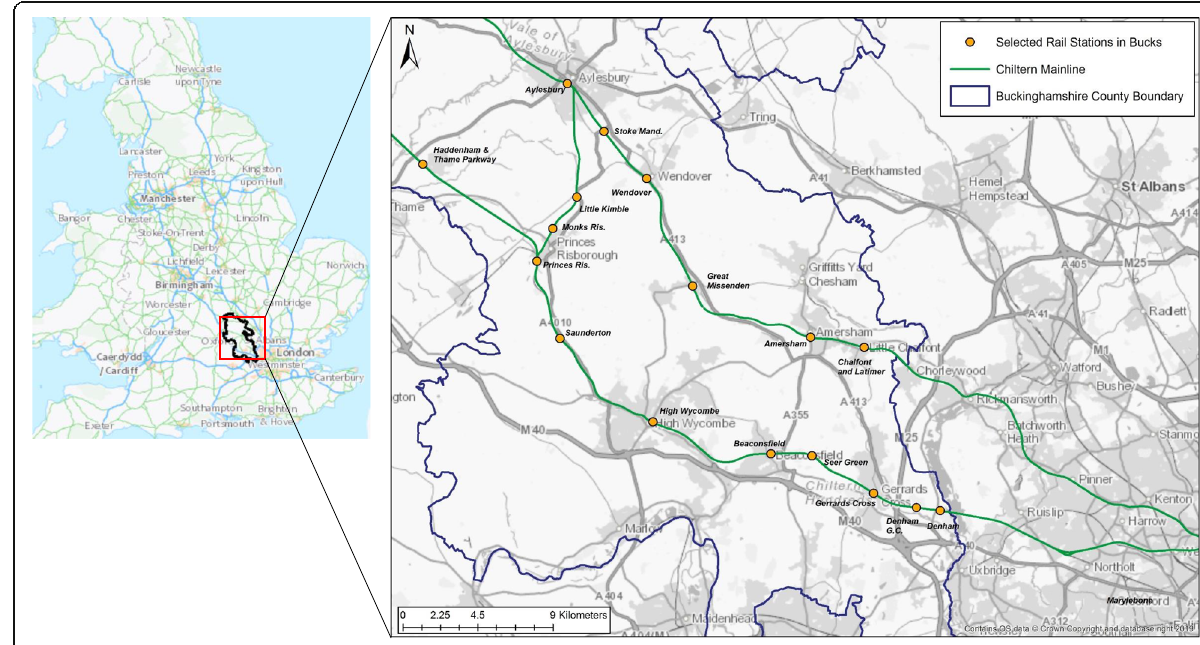
Fig. 2 Study area and case study locations (Source: Authors ’